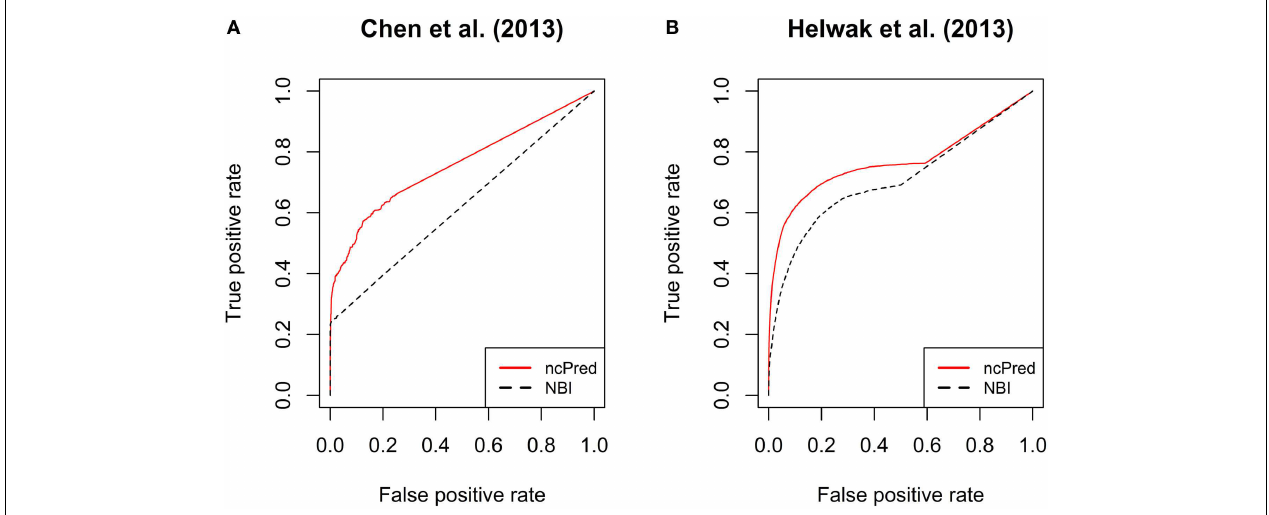
rate. (A,B) are independent since computed on two separate datasets.The significance of the difference highlighted between ncPred andYang et al. (2014) was measured by applying the Friedman rank sum test as assessed in Table 4